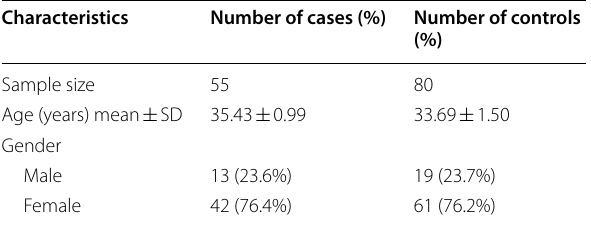
Table 2 Demographical characteristics of migraine patients and healthy controls